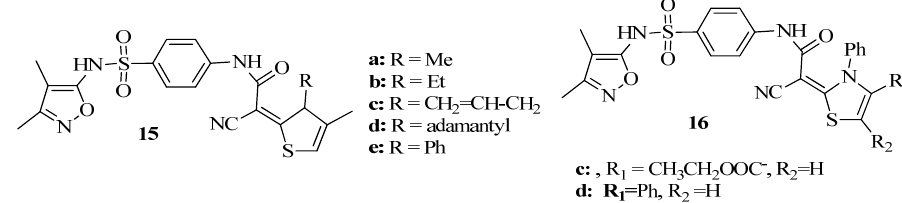
Figure 7. Structures of 2,3-dihydrothiazoles tagged with sulfisoxazole moiety.